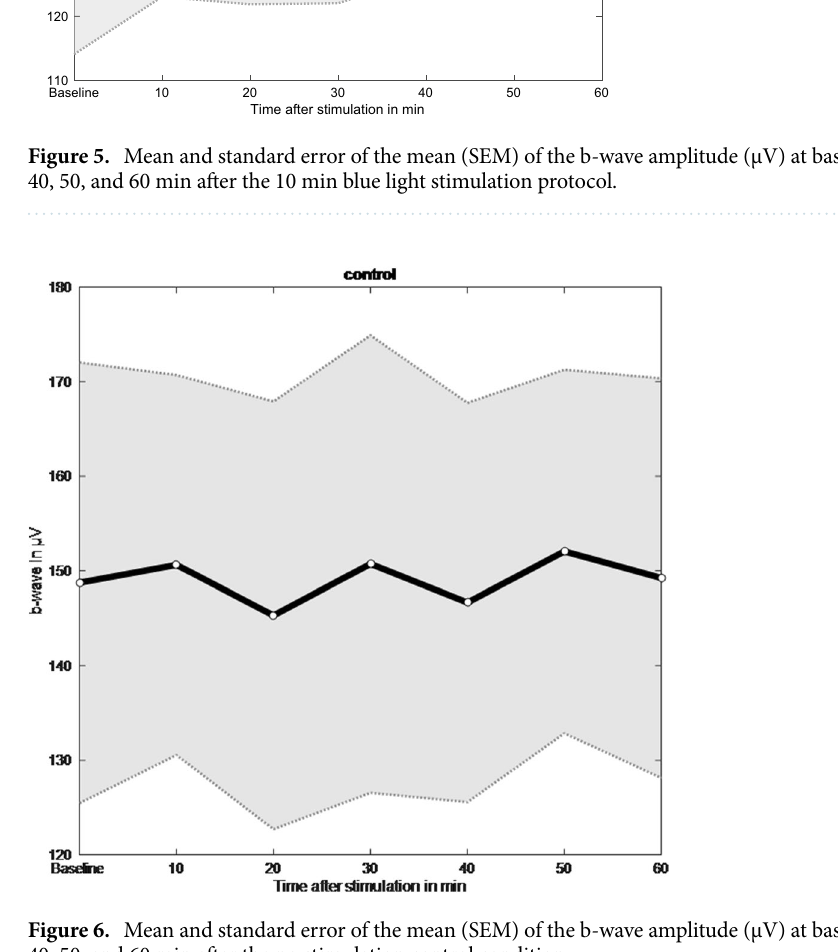
Figure 6. Mean and standard error of the mean (SEM) of the b-wave amplitude (µV) at baseline and 10, 20, 30, 40, 50, and 60 min after the no stimulation control